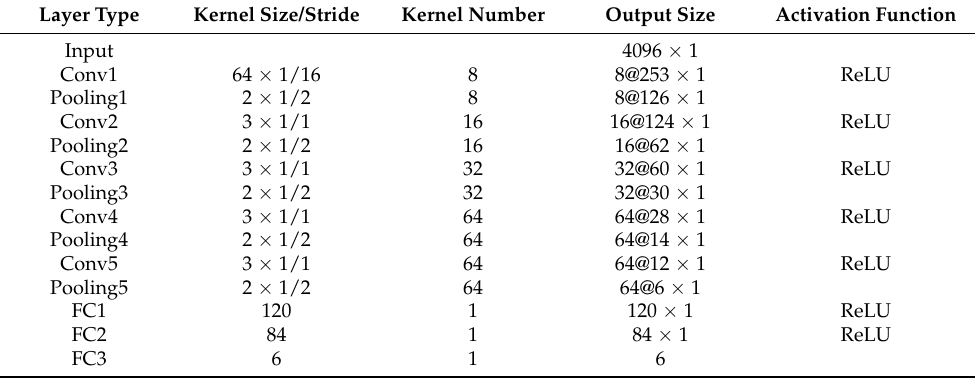
Table 2. Detailed settings of the